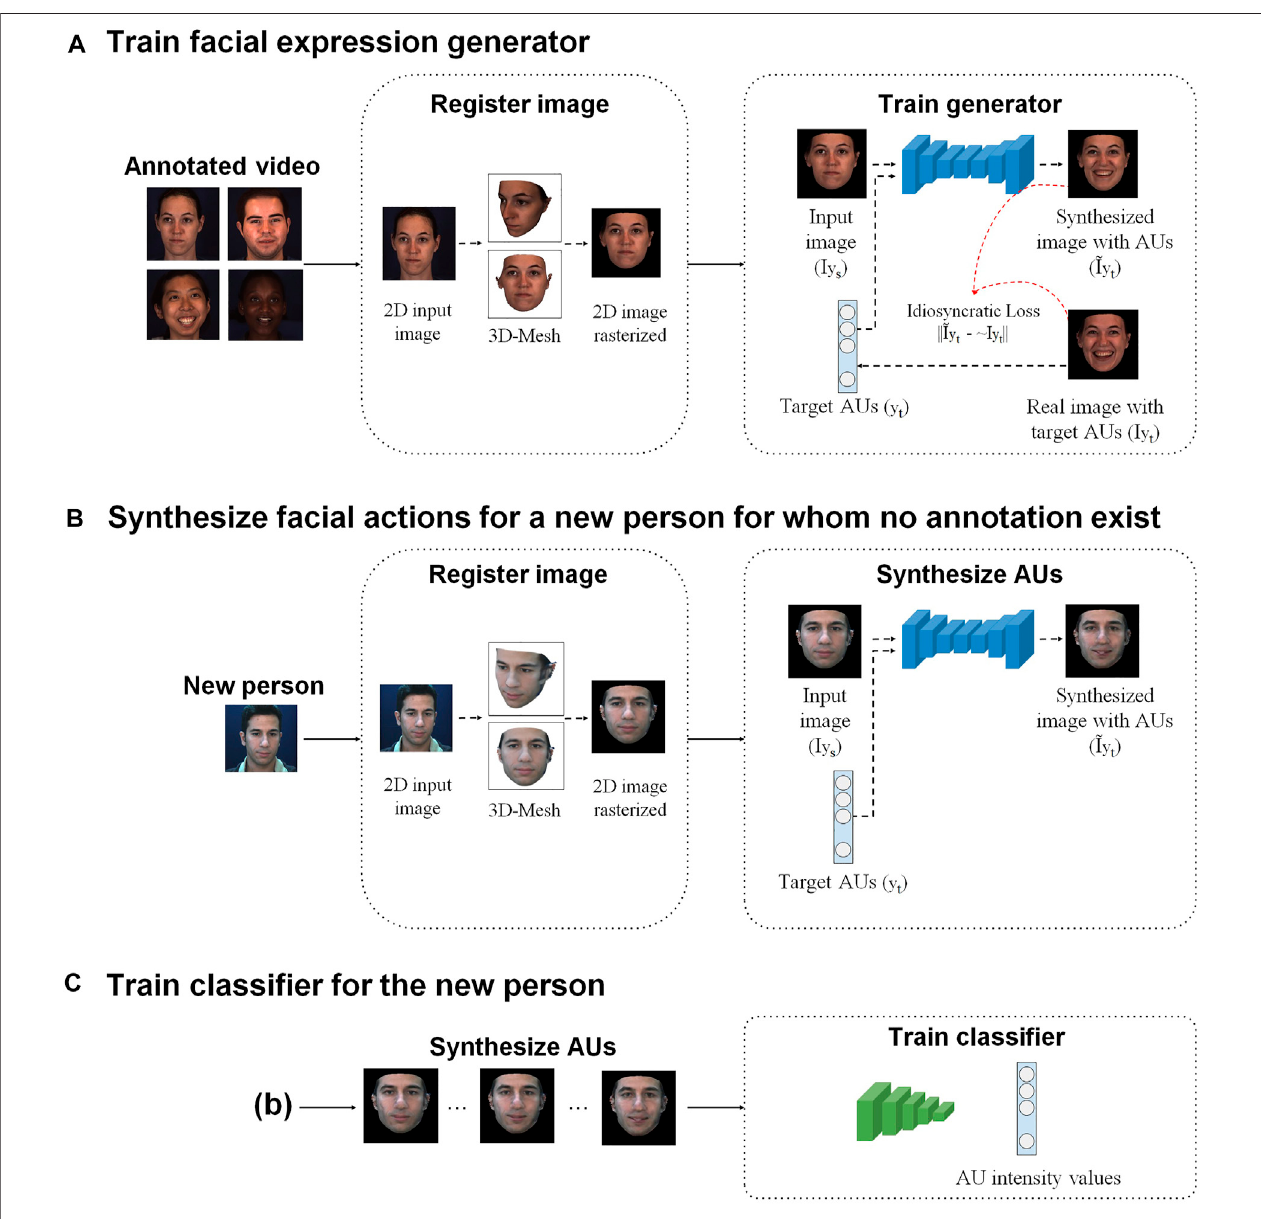
FIGURE1| Pipelineofourapproach. (A) Adense3Dmeshofthefaceisreconstructed fromeachannotatedvideoframe,rotatedtothecanonicalfrontalview,and 2D rasterized. Then, a GAN-based network is trained to synthesize a novel image with target AUs ( y t ). The same trained network is used to synthesize images of both persons in the database and new persons. (B) Given a single registered input image ( I y Synthesis expressions are generated with varying AU intensity labels, and they are used to personalize pre-trained networks.